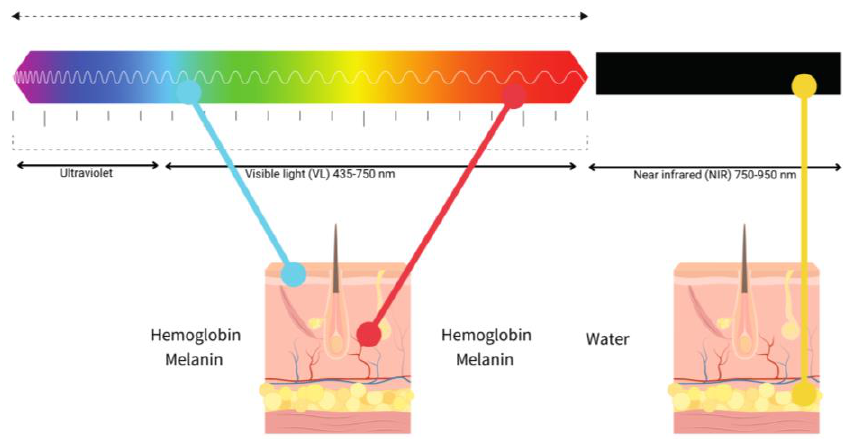
Figure 4. Diagram of the relationship between visible light (blue, red) and near-infrared (NIR), penetration and chromophores.